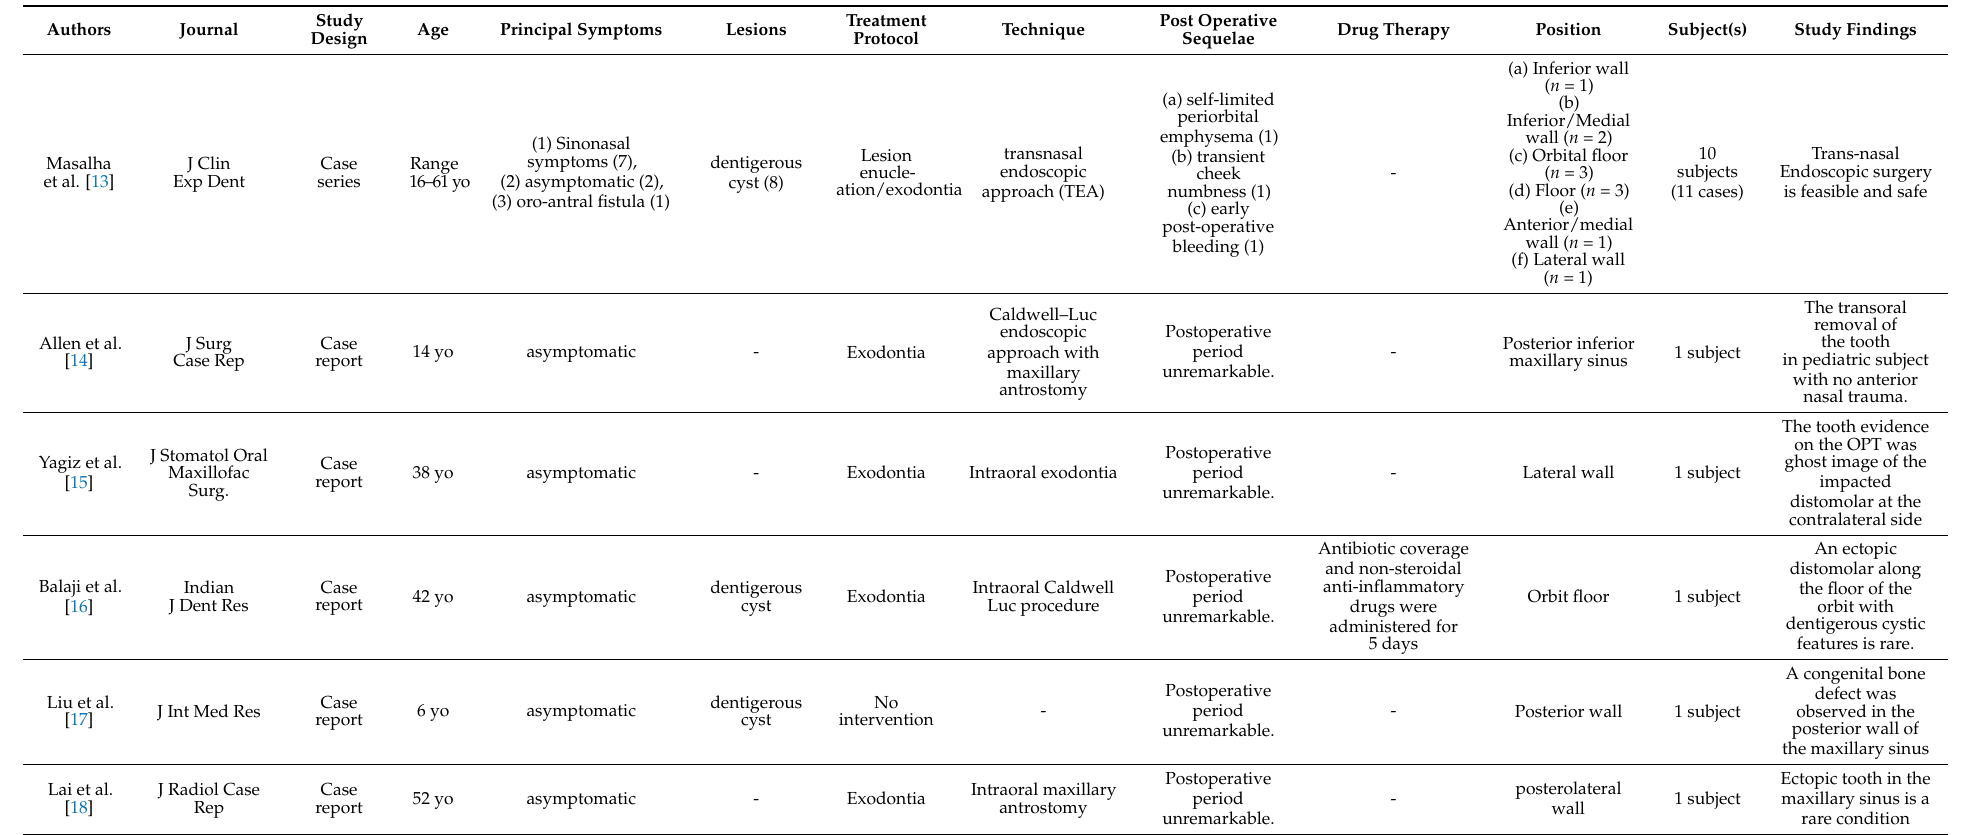
Table 2. Articles selection descriptive